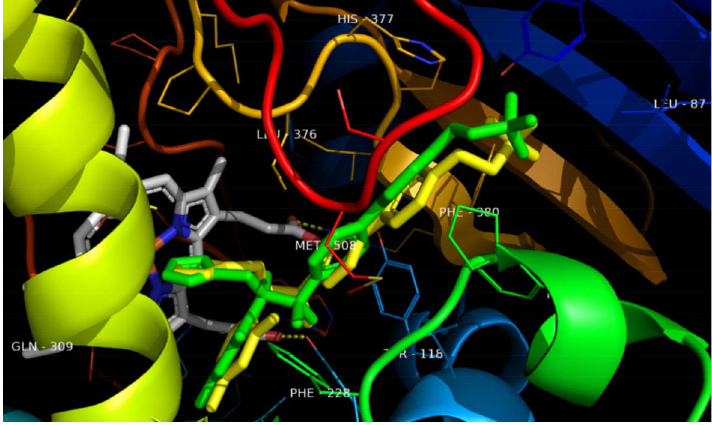
Figure 2. Overlapping VT-1161 (oteseconazole) ligand from lanosterol 14 a -demethylase with best conformation in redocking. Green: Protein Data Bank co-crystal. Yellow: binder conformation after redocking.